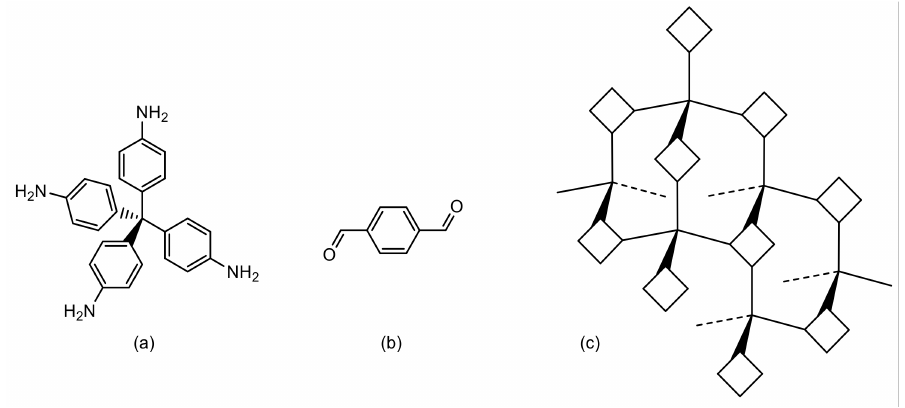
Figure 2. Structure of ( a ) TAPM and ( b ) BDA monomers and ( c ) schematic 3D structure of